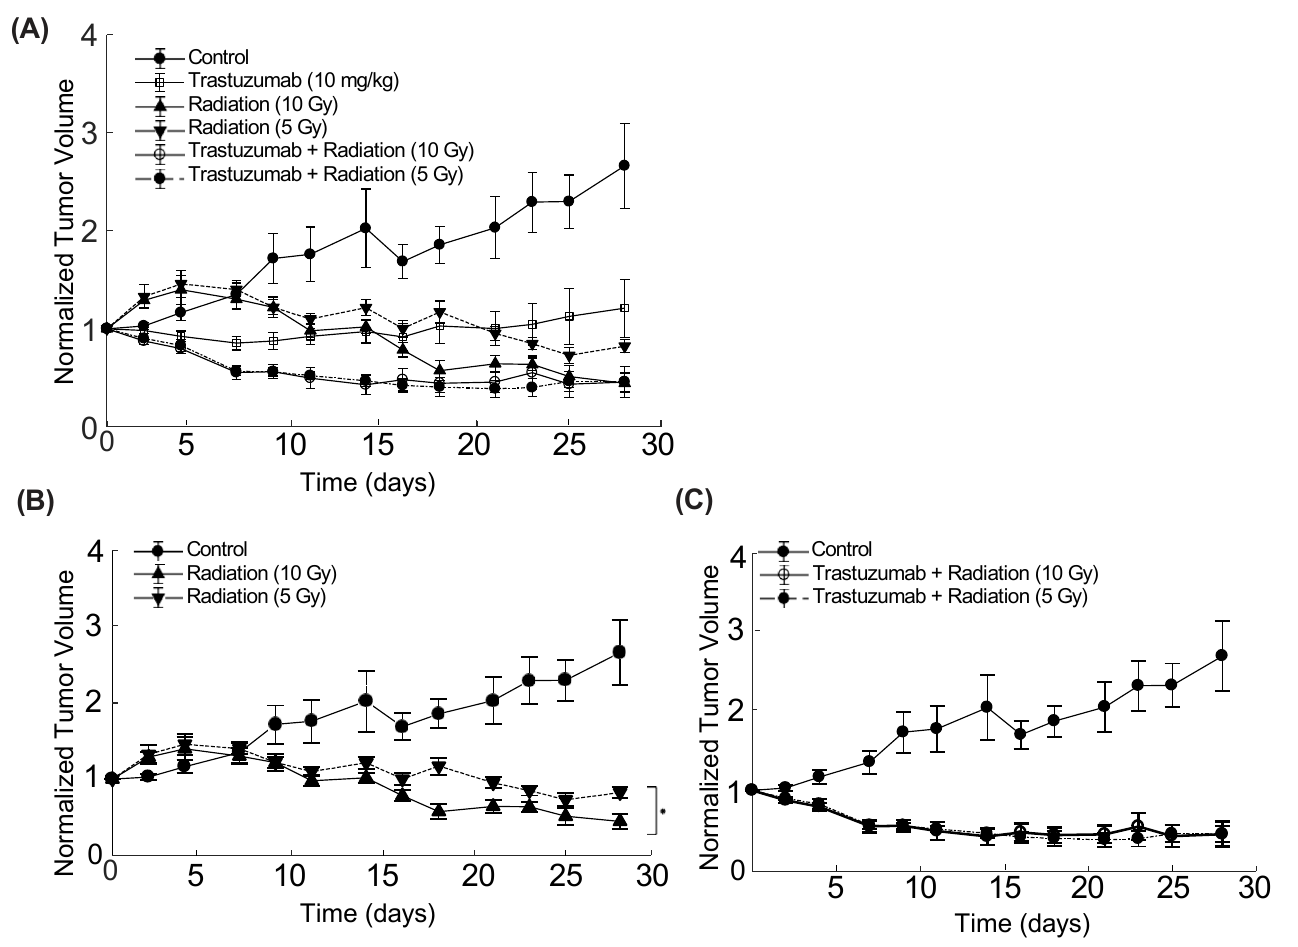
Figure 6. In vivo tumor growth response to single-agent and combination trastuzumab and radiation therapy. All mice were treated with radiation on Day 0 and trastuzumab on Days 0 and 3. ( A ) All groups. ( B ) Control with single-agent radiation therapy. There was a significant difference between groups treated with single-agent 5 Gy and single-agent 10 Gy radiation (* p < 0.001). ( C ) Control with trastuzumab and radiation (5 Gy), and trastuzumab and radiation (10 Gy). There was no significant difference between the radiation-treated groups when adding trastuzumab to the regimen ( p = 0.56).